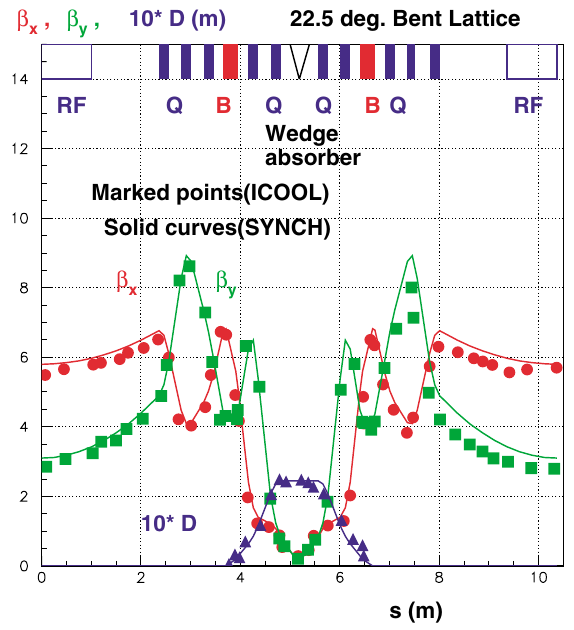
, @ , and D (dispersion) in a 22 : 5 (cid:28) x y